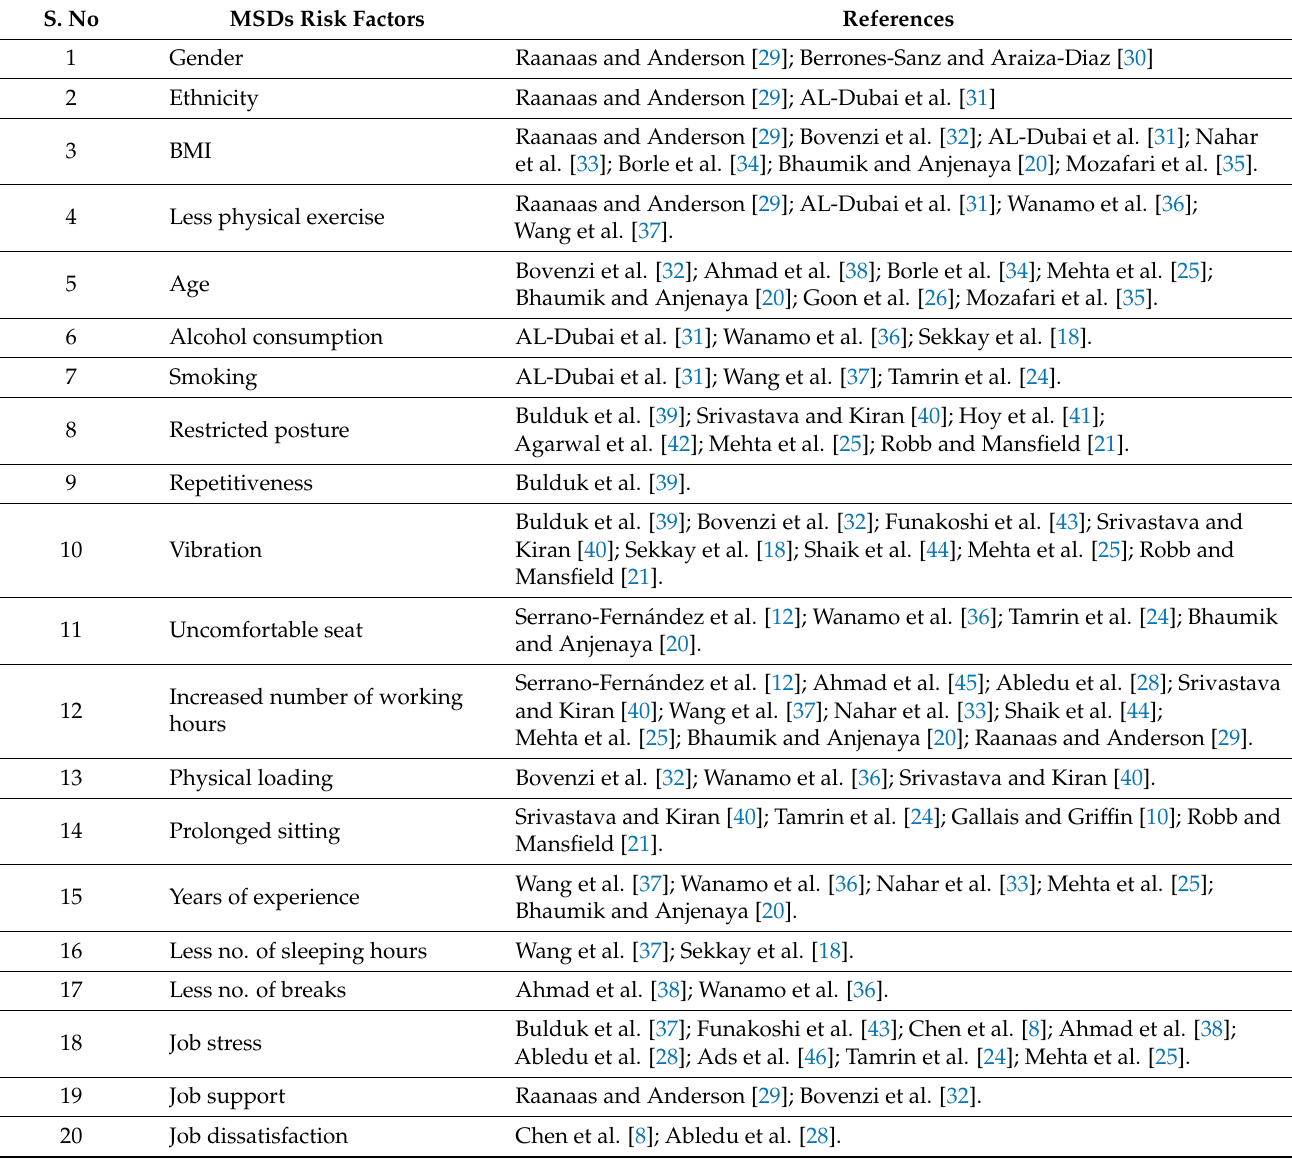
Table 1. MSDs risk factors identified from the